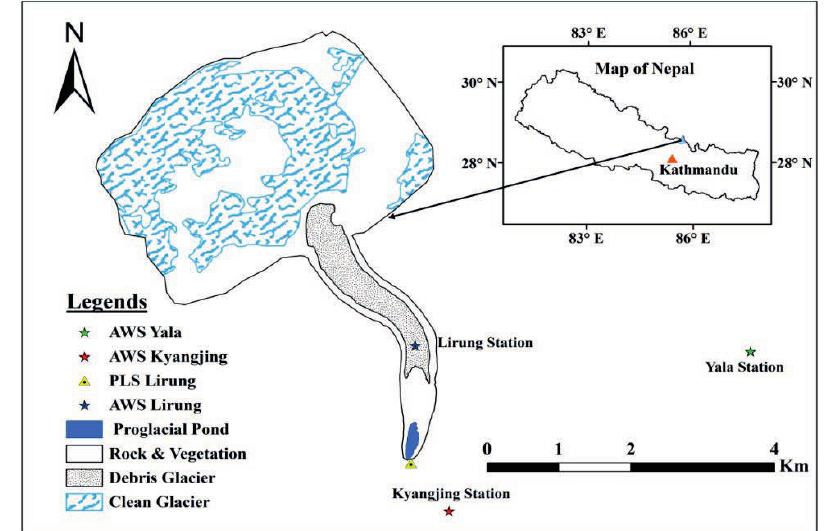
Fig. 1 Location map of the study area showing location of AWS and